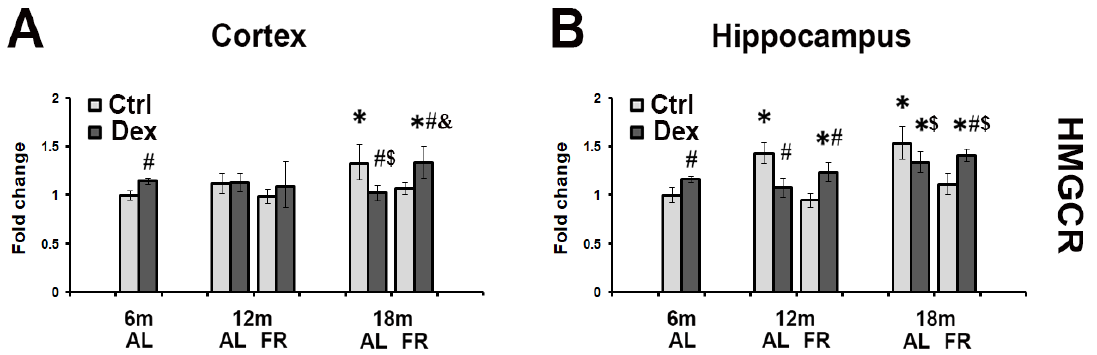
Figure 2. The effects of dexamethasone on HMGCR mRNA level in the cortex ( A ) and hippocampus ( B ) of rats fed ad libitum (AL; light gray bars) and following long-term food restriction (FR; dark gray bars) during aging. Dexamethasone was applied in a dose of 4 mg/kg (single i.p. injection). Values were obtained by semiquantitative qRT-PCR. Histogram represents mRNA levels expressed as ratio (fold change) calculated relative to the values obtained in 6-month-old rats. In order to obtain the differences between the experimental groups, nonparametric Mann–Whitney U Test was performed ( n = 5 rats per group). * p < 0.05 vs. 6-month-old rats; # p < 0.05 vs. vehicle-treated rats, $ p < 0.05 vs. 6-month-old rats treated with Dex; & p < 0.05 vs. age-matched AL rats treated with Dex.